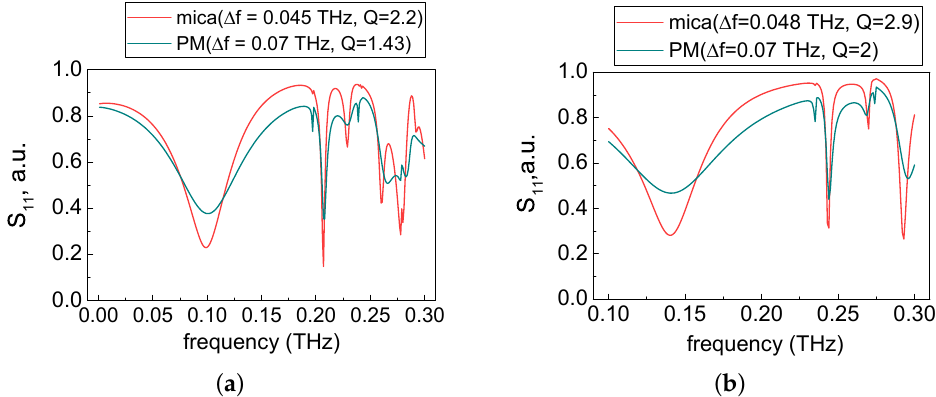
Figure 5. Reflection amplitude spectrum of Bi 88 Sb 12 -based FSS on different substrates under the exposure at different frequencies: ( a ) under 0.1 THz exposure ( b ) under 0.14 THz